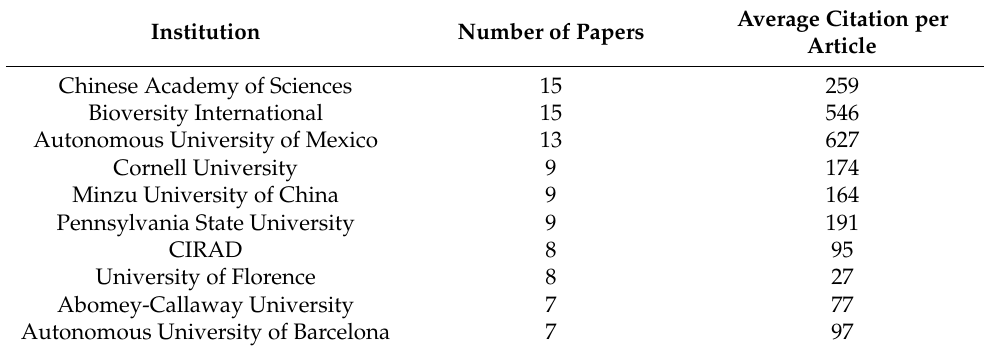
Table 4. Top 12 institutions in a number of